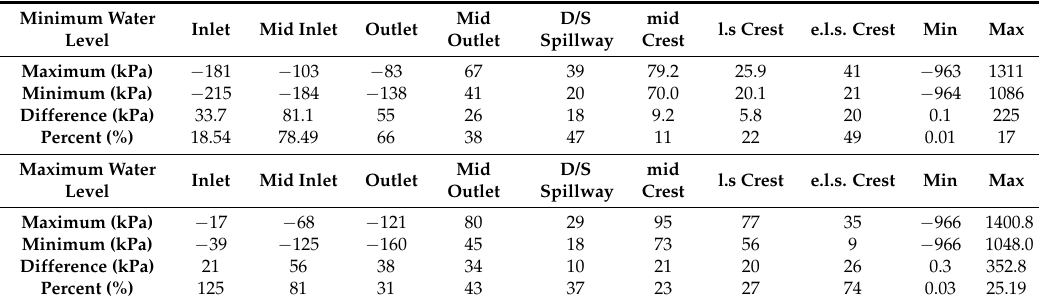
Table 6. Statistical analysis of the principal stress results of the Haditha dam according to the running turbines at maximum and minimum upstream water levels.